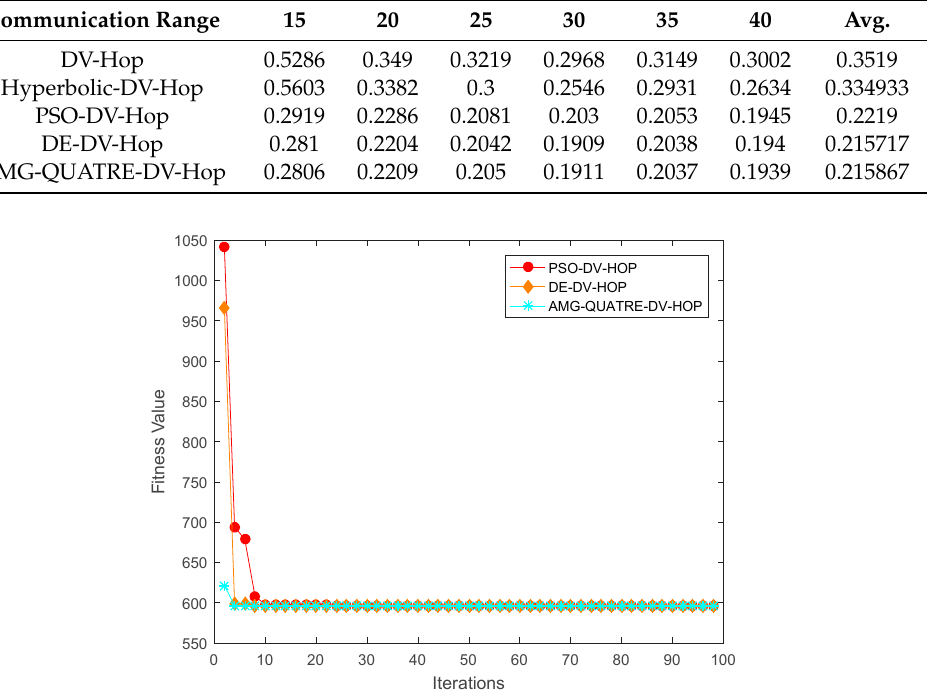
Figure 10. Comparison of convergence curve of the applied AMG-QUATRE with PSO and DE methods for single simulation (Number of sensor node 200, Number of anchor node 20, Communication range 40).